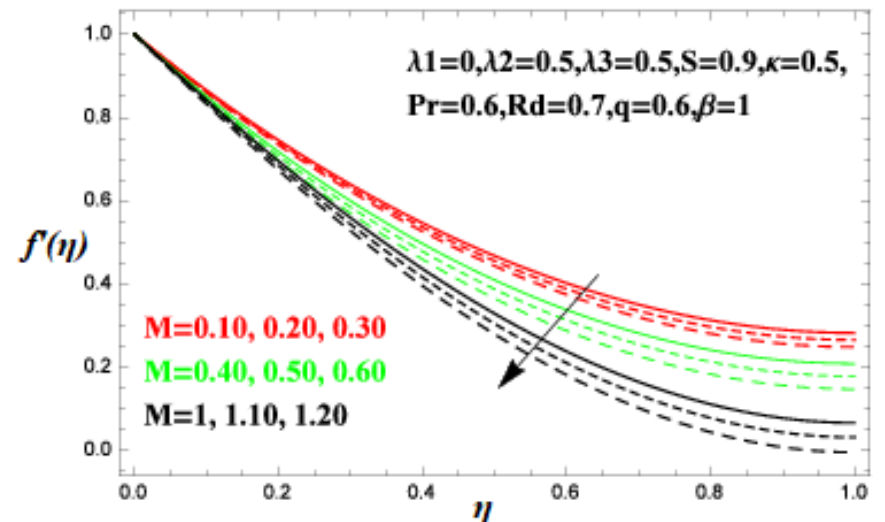
Figure 6. Dissimilarities in f ( η ) for di ff erent numbers of M .